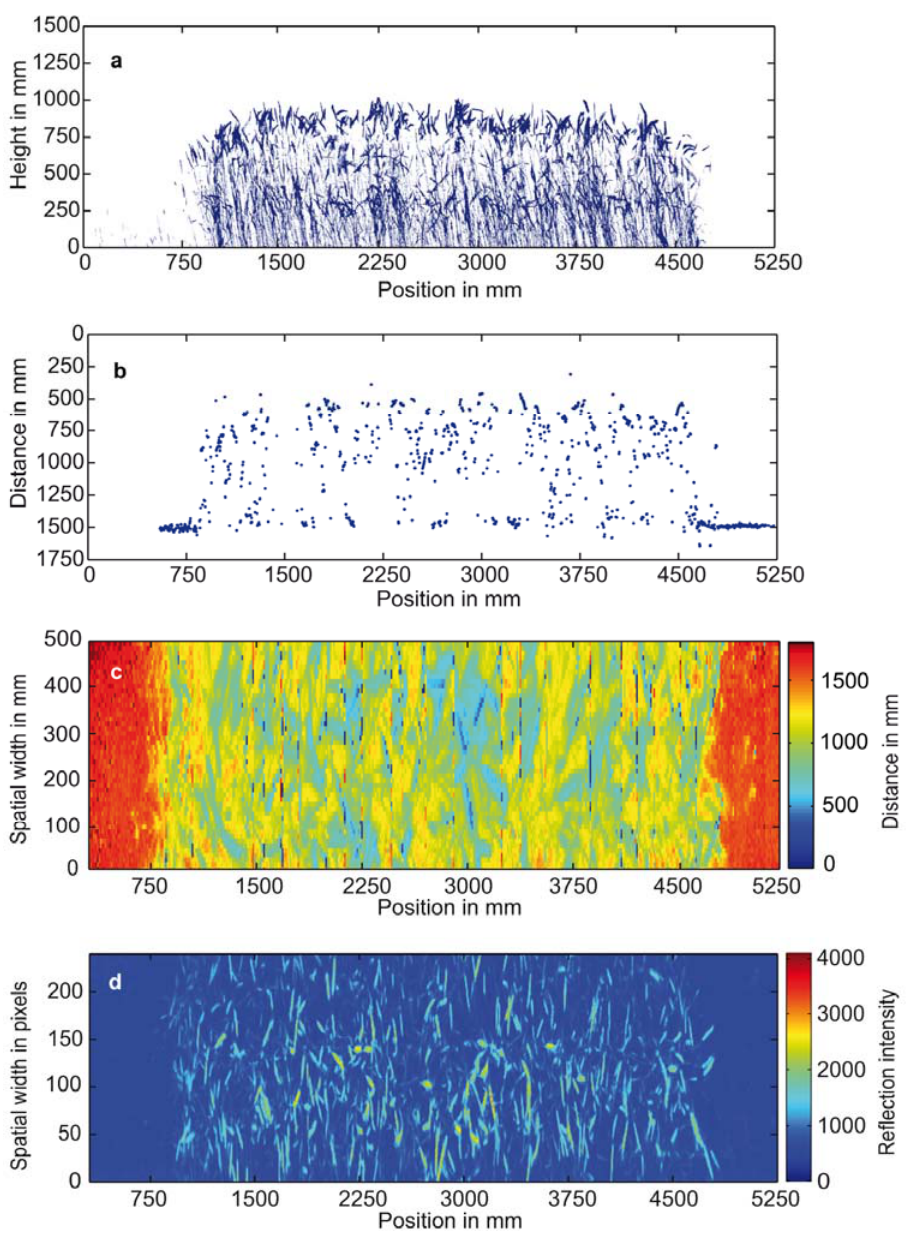
Figure 5. Information gathered per plot for ( a ) light curtains, ( b ) laser distance sensor measuring from top into the plant cover, ( c ) 3D Time-of-Flight camera measuring from top, and ( d ) hyperspectral imaging, (exemplarily shown for 970 nm) measuring from